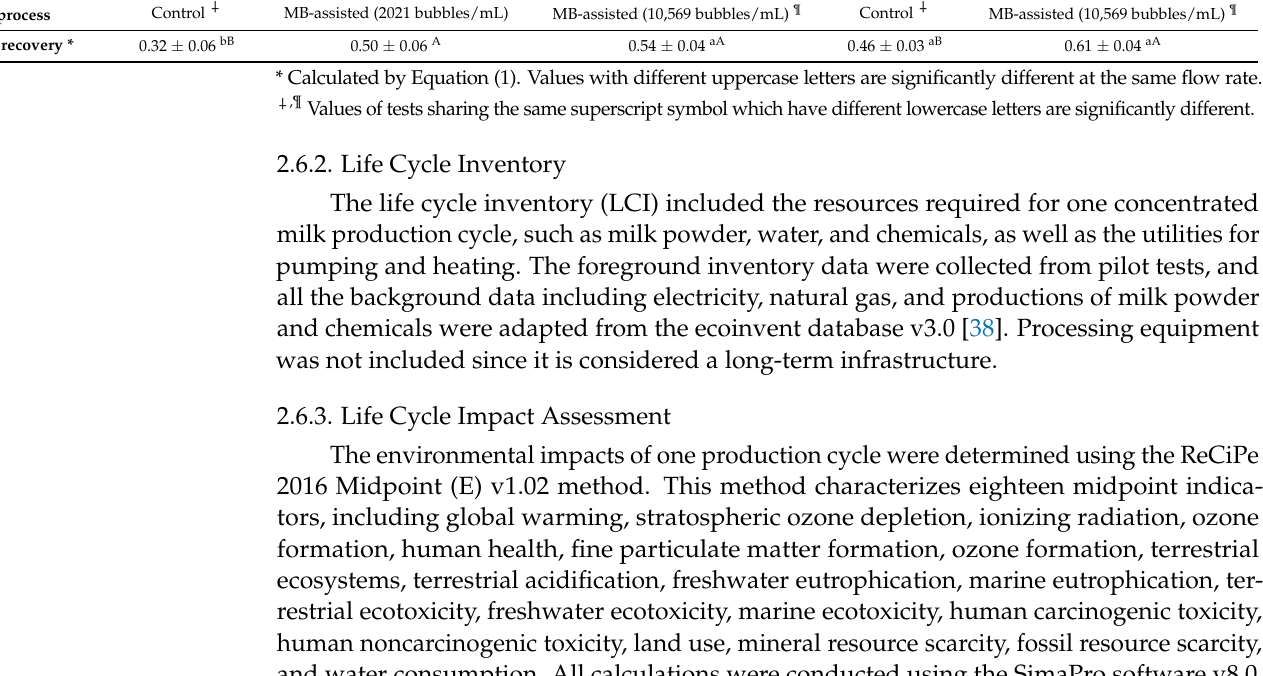
Table 2. Membrane flux recovery of control and MB-assisted CIP processes for UF membranes fouled by model milk.